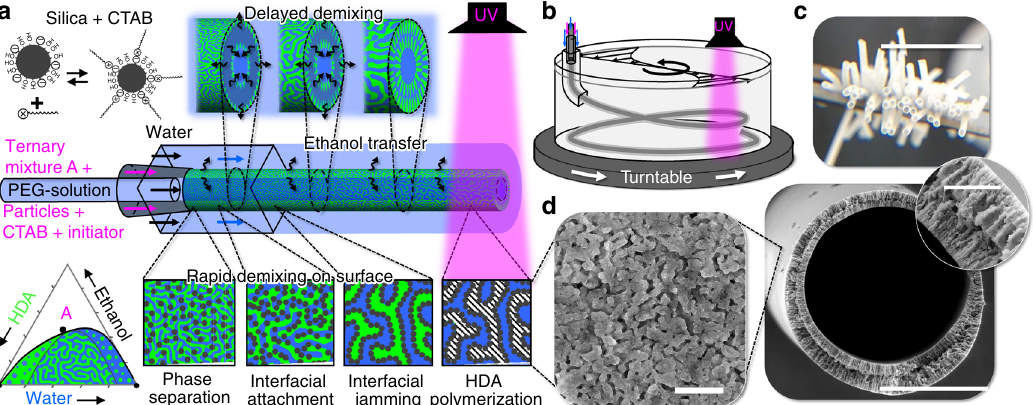
Fig. 1 Formation of hollow fi ber membranes by STRIPS. a Schematics of hollow fi ber membrane formation. The co-extrusion of a silica nanoparticle doped monomer solution (ternary fl uid) and water (bore fl uid and sweeping fl uid) yields a hollow fi ber. To produce a uniform hollow core, the bore- fl uid nozzle must be centered, (as is assured by a square capillary that serves to fi x its location, see Supplementary Methods), and the bore fl uid viscosity must be adjusted by addition of high molecular mass polyethylene glycol (1 wt% PEG, 600 kDa). Rapid solvent transfer to the outer water phase and to the bore fl uid induces phase separation on the fi ber surfaces. Delayed solvent transfer in the radial direction generates aligned internal macrovoids. Interfacial nanoparticle jamming yields a nanoparticle-stabilized bicontinuous liquid monomer/water scaffold on the fi ber surface. The monomers are polymerized by UV-light irradiation, resulting in a hollow, porous polymer/nanoparticle composite fi ber. b Aligned fi bers are collected in a rotating glass cylinder fi lled with water. Fiber exiting the ori fi ce is guided to horizontal orientation by the curved outer channel. Prior to polymerization, the hollow nanoparticle-stabilized liquid fi bers are fragile (tensile strength ranging from 0.6 to 4 kPa) 35 ; fl ow- and collection bath rotation must be delicately controlled to prevent fracture and defect formation (see Supplementary Methods, Supplementary Note 6). However, upon polymerization, the hollow fi ber membrane can be washed and dried without compromising structural integrity. c Photograph of dried hollow fi ber membrane, scale bar 0.5 cm. d SEM micrographs reveal the internal (scale bar 200 µ m, inset 20 µ m) and surface structures (scale bar 5 µ m) of fi bers fabricated with ternary fl ow rate Q T = 10 ml h − l and bore fl uid fl ow rate